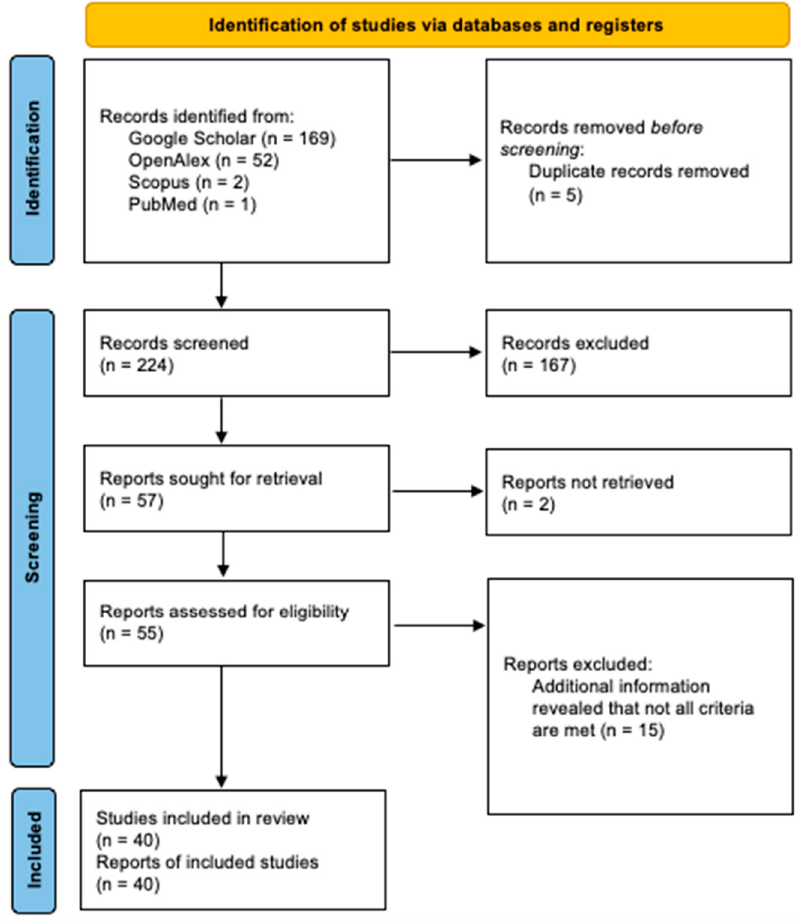
Figure 1. PRISMA diagram of the study selection process.